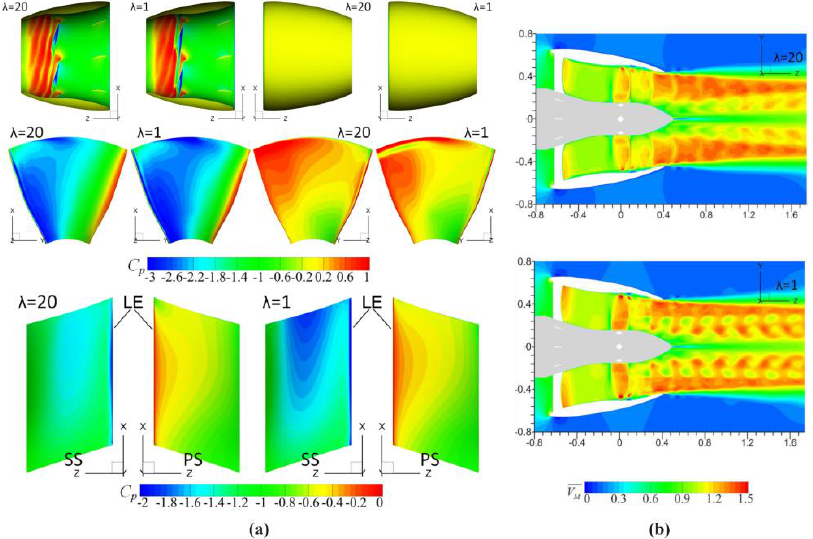
Figure 6. Stress nephogram and vortex diversities between the full scale and the model scale. ( a ) The pressure distribution on each component of the pump-jet; ( b ) the velocity distribution in x = 0 plane.